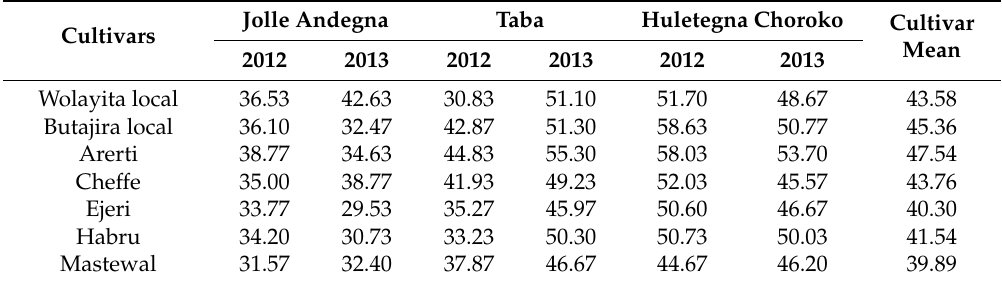
Table 8. Grain zinc concentration (mg · kg − 1 ) of 15 chickpea cultivars and breeding lines tested under zinc fertilized soil across three locations in southern Ethiopia during the 2012 and 2013 growing